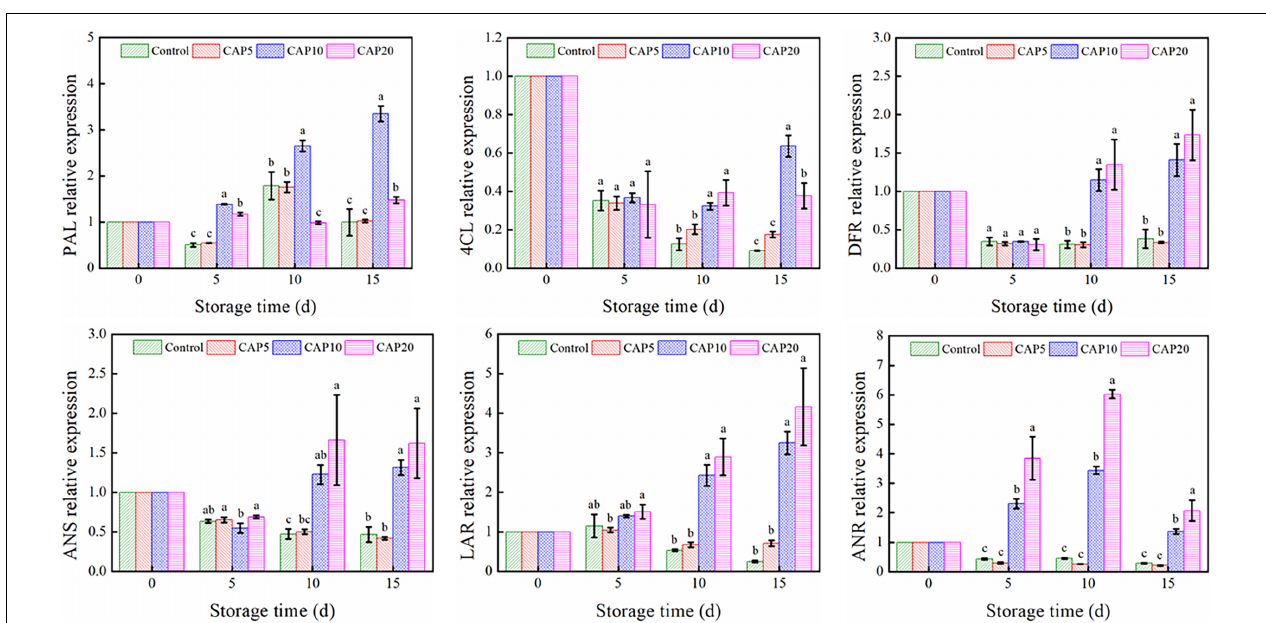
Data are recorded as mean ± SD. Small and capital letters show the similar meanings as Figure 2 .